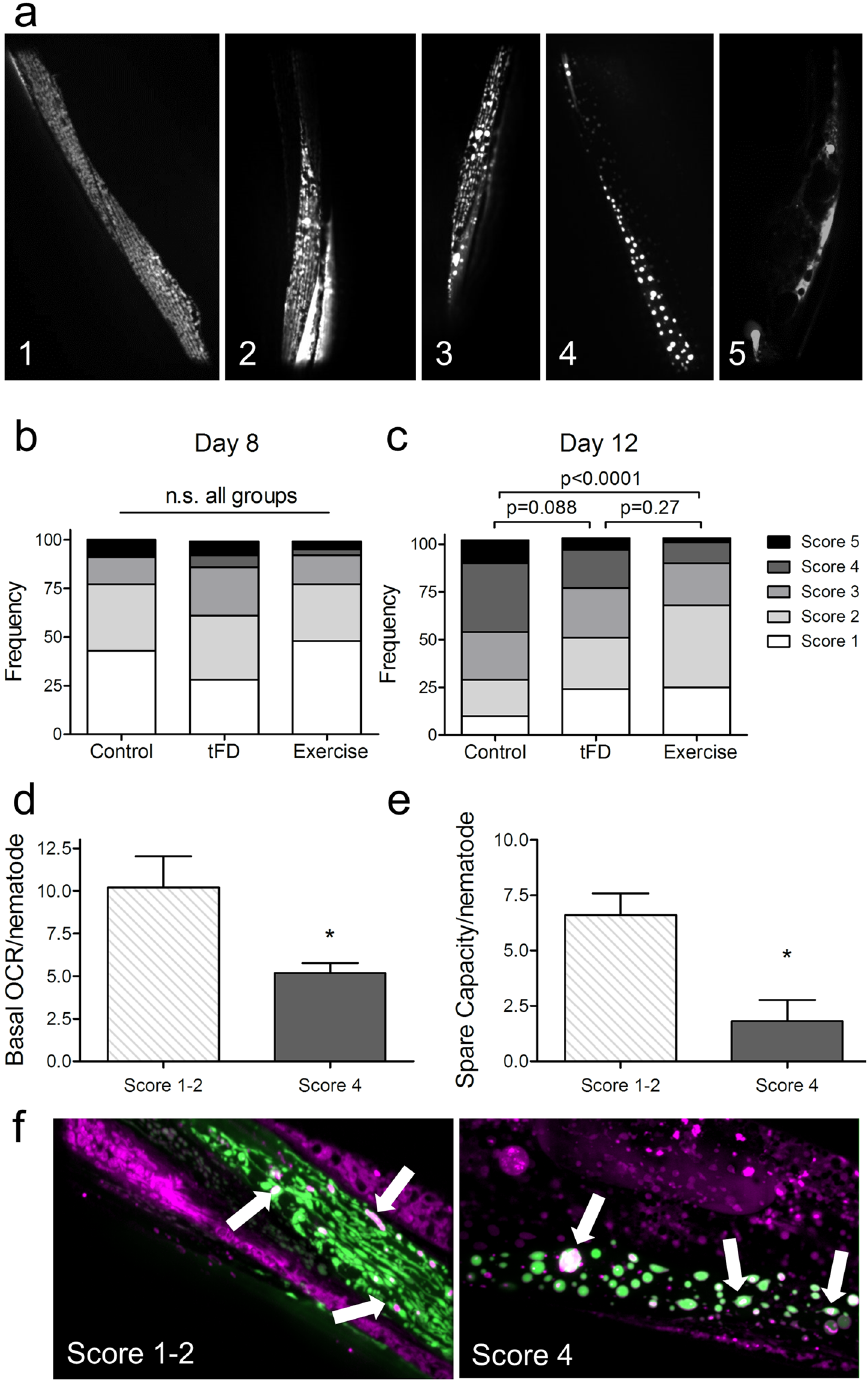
Figure 2. Exercise protects from aging-induced deterioration of body wall muscle mitochondrial morphology. Panel a, representative images demonstrating the scoring system used to visually discriminate different morphologies. Images were taken in the distal posterior (tail region) of the animal to maximally avoid bright autofluorescence of the gut. Score 1 represents highly abundant, highly networked mitochondria with little or no blebbed appearance, while score 2 has highly abundant, networked mitochondria with some blebbing. Score 3 has less abundant mitochondria with gaps in the network and more blebbing, and score 4 has very sparse, enlarged mitochondria. Finally, score 5 was a severe phenotype in which no muscle GFP could be detected (shown in the image is autofluorescence in the tail region). Panel b represents score distributions on day 8 and Panel c scores on day 12. The Y-axis represents the frequency (proportion of 100%) for each score. Images were loaded into a blinding scoring software written in-house for this purpose (see Methods). Data shown represent three individual biological replicates, each with 10–25 animals per group. Global statistical difference among the three distributions was determined using a Chi-squared test, followed by pairwise